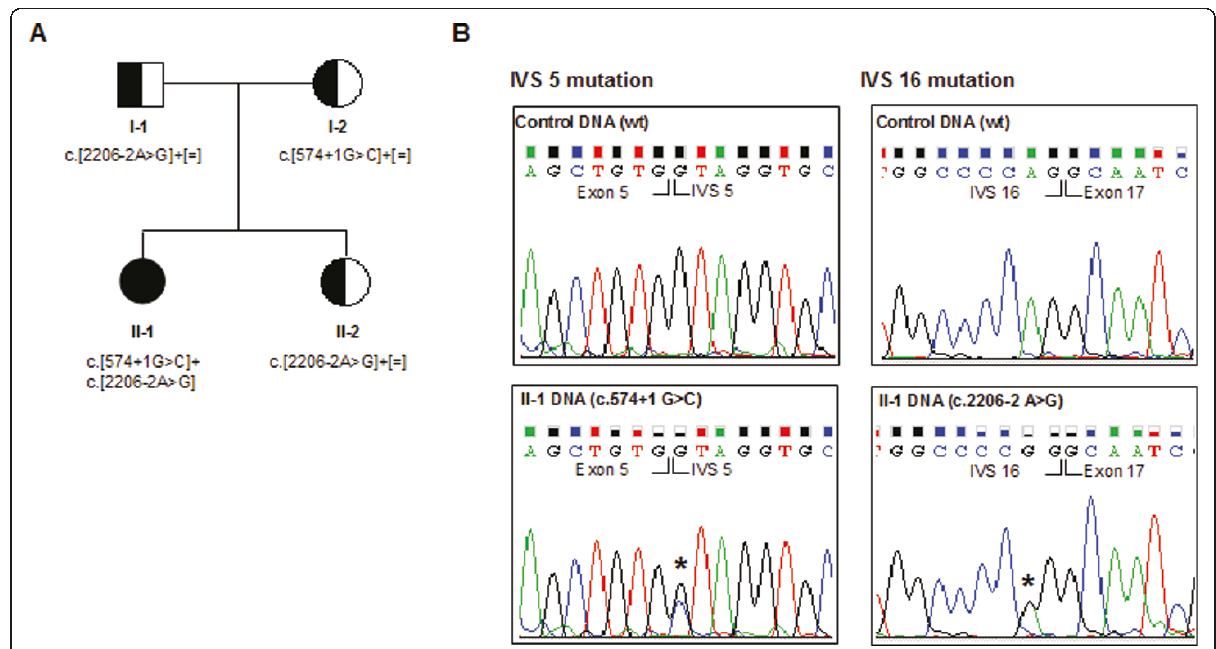
Figure 1 Pedigree of the family and results of the NTRK1 genetic analysis in CIPA patients ’ DNA . A . As indicated by the symbols in the pedigree, individual II-1 is affected by CIPA, whereas her parents and sister are all carriers. The NTRK1 mutation detected in each individual is indicated under the corresponding symbol. B . Electropherograms demonstrating the presence of two NTRK1 point mutations (in IVS5 and IVS16) in DNA from individual II-1. The position of each mutation is indicated by an